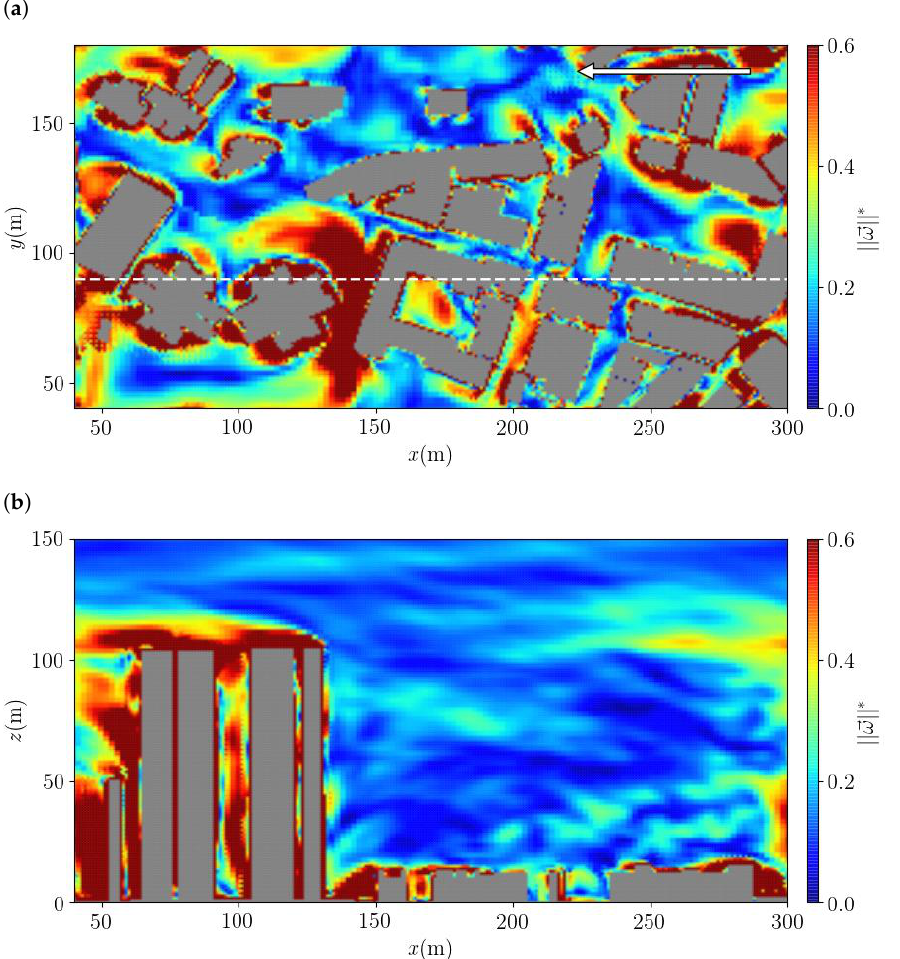
Figure 14. Time-averaged normalised vorticity magnitude for the Central neighbourhood and an external easterly wind (indicated by the arrow): ( a ) x y = 90 m (indicated by the white dashed line in panel